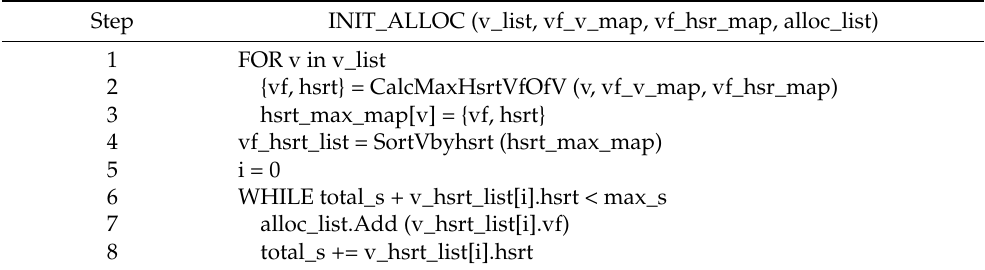
Table 1. Pseudo-code for initializing the storage resource allocation algorithms